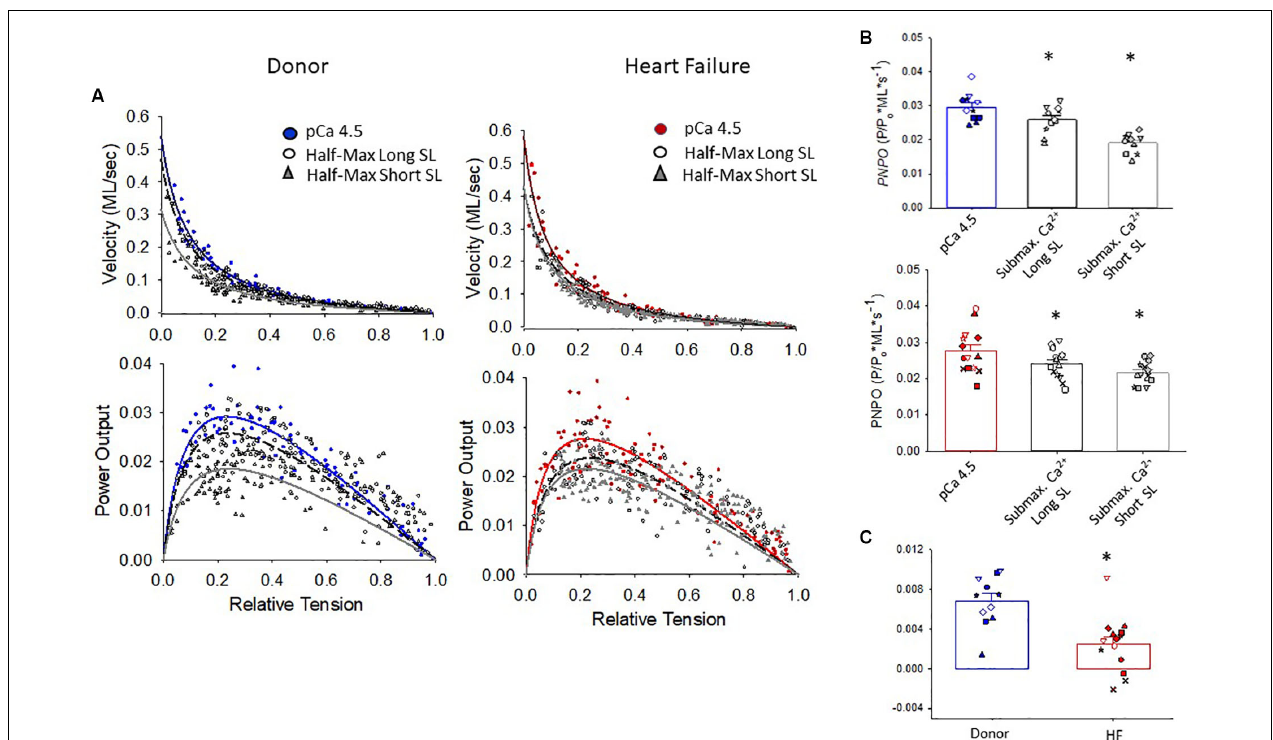
FIGURE 6 | Normalized force-velocity and power-load curves. (A) Cumulative force-velocity and power-load curves from donor and HF preparations. (B) In myocyte preparations from organ donors and patients with heart failure, the peak normalized power output (PNPO) was lower at half-maximal Ca 2 + activation than at maximal Ca 2 + activation (* p = 0.027 or lower depending on comparisons). (C) Sarcomere length dependence of PNPO (that is, PNPO at long SL half max – short SL half-max) was significantly reduced in failing samples, * p = 0.004. Different symbols indicate data points from each heart sample. All tests were performed using the linear mixed